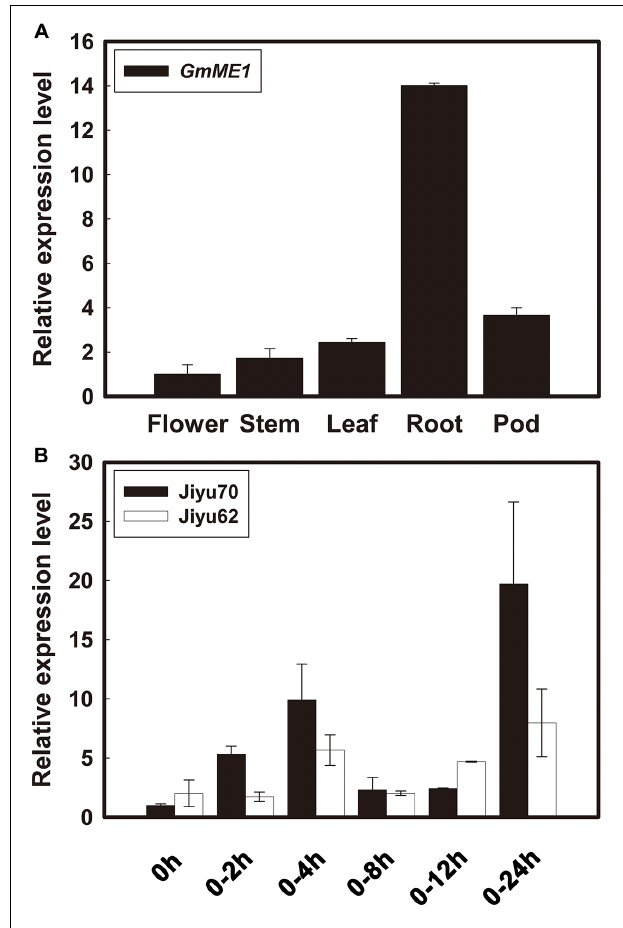
FIGURE 3 | Transcriptional expression patterns of GmME1 in soybean. (A) Tissue localization expression of GmME1 . After 18 days of growth in the field, the roots, shoots, leaves, flowers and pods were sampled from Jiyu 70 soybean seedlings. (B) Four-day-old seedlings were cultured in 0.5 mM CaCl 2 solution containing 30 µ M AlCl 3 (pH 4.5) for 0, 2, 4, 8, 12, and 24 h. Total RNA was extracted from root apices (0–1 cm). qRT-PCR was performed using the β -tubulin gene as an internal standard with 0 h seedling root apices as a calibrator. Data are given as the mean ± SD ( n =